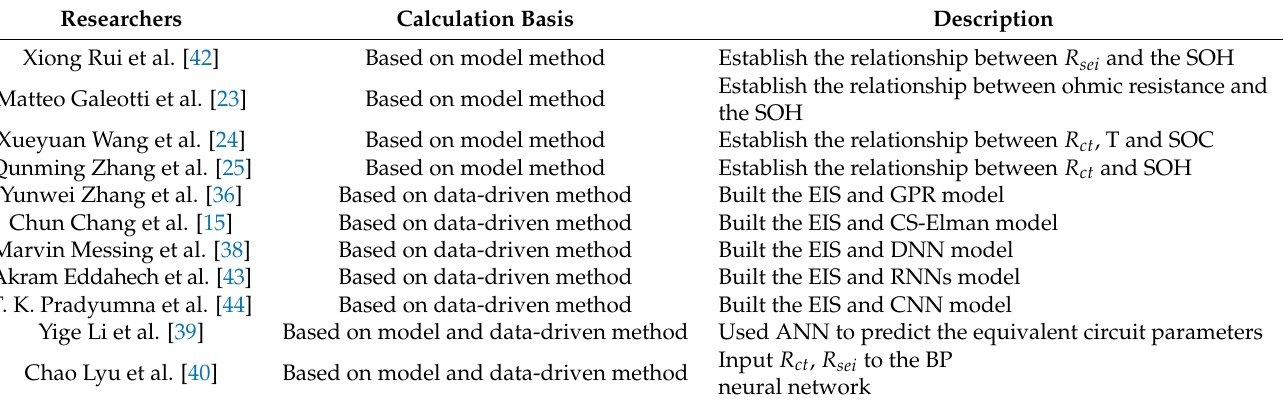
Table 2. Typical studies on predicting SOH based on